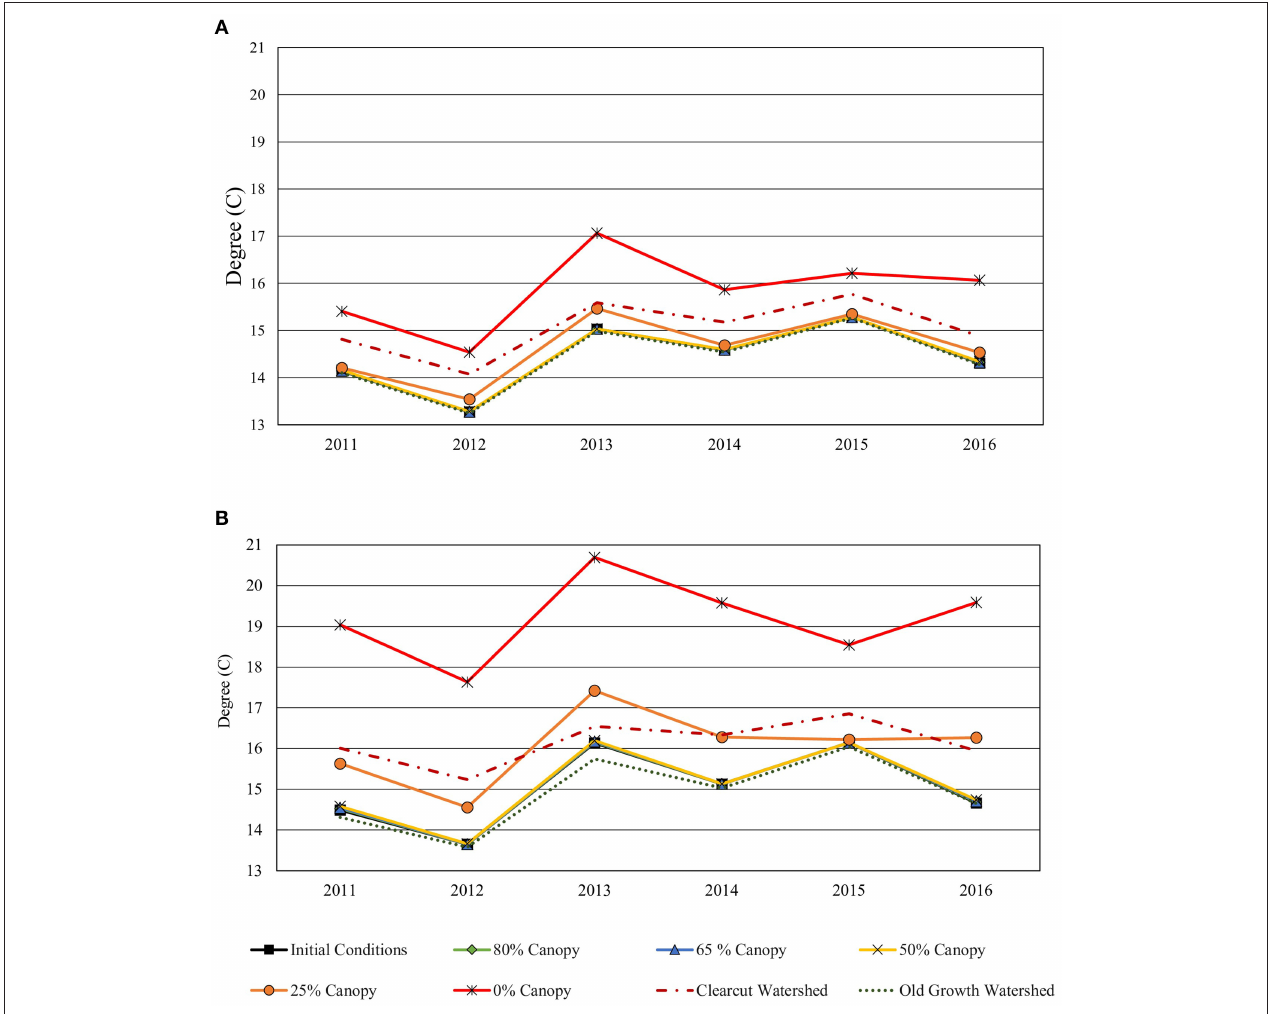
FIGURE 8 | Simulated (A) MWAT and (B) MWMT temperature results for the South Fork mainstem outlet when reducing canopy cover in all stream segments. Solid lines use pre-harvest, second and third-growth vegetation conditions across the watershed, with varying canopy cover in the buffer areas. Dashed lines alter both the watershed and buffer area